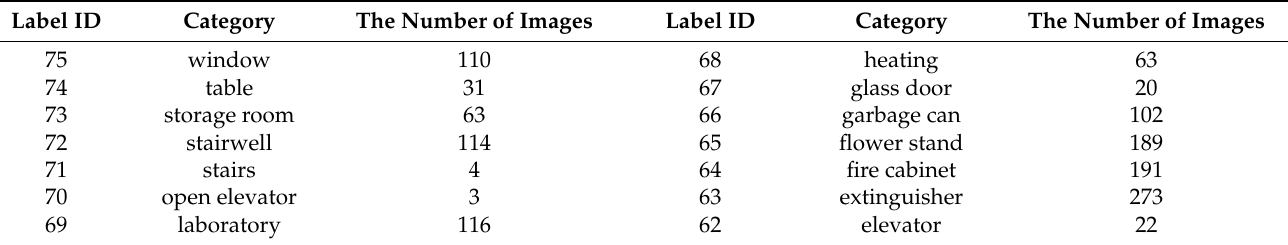
Table 3. mAP with different hyperparameters.